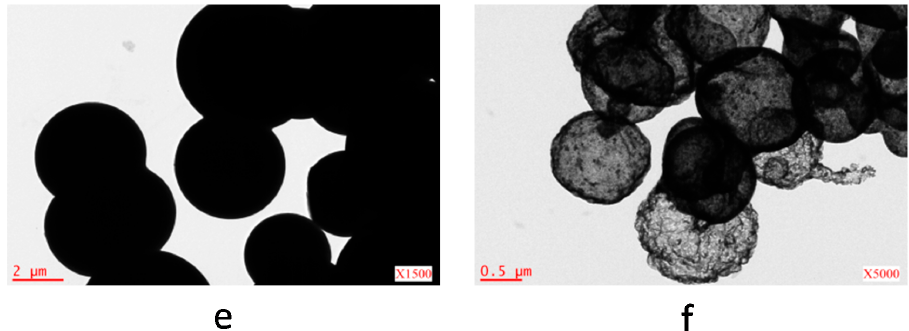
Figure 4. Materials produced by HTC of (NH 4 ) 2 Fe(SO 4 ) 2 · 6H 2 O–Mimosa tannin solution at different magnifications: before ( a , c , e ) and after ( b , d , f ) calcination in air; SEM ( a – d ) and TEM ( e , f ) pictures.